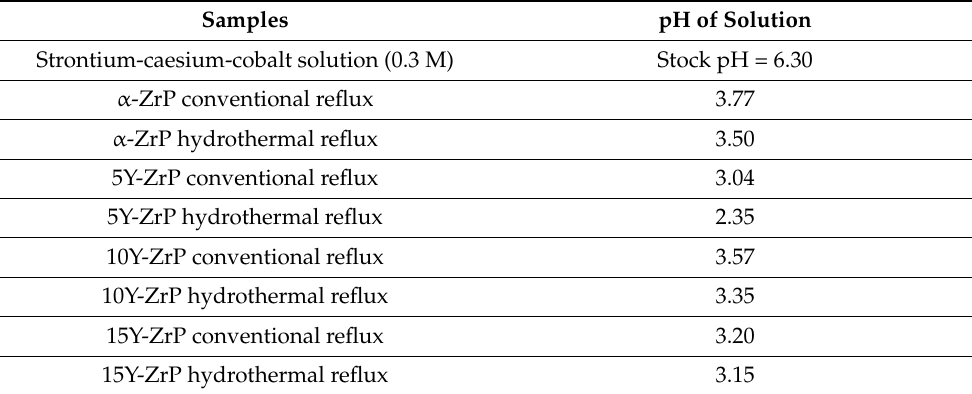
Table 11. Summary of the pH results of strontium–caesium–cobalt